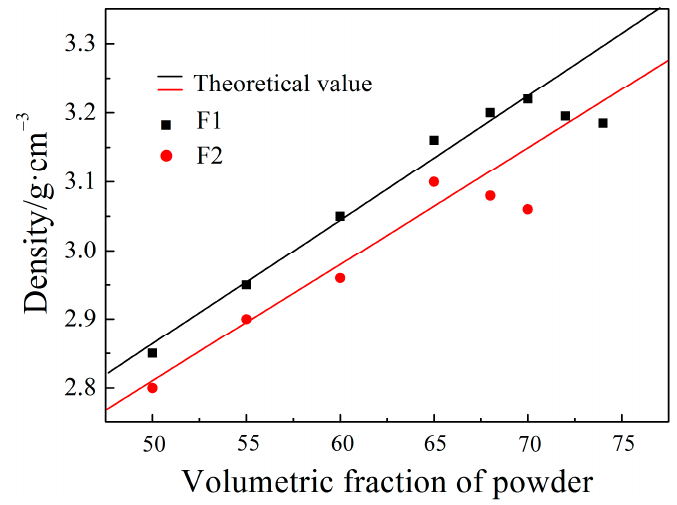
Figure 2. Variation in the density of feedstocks with powder loading.